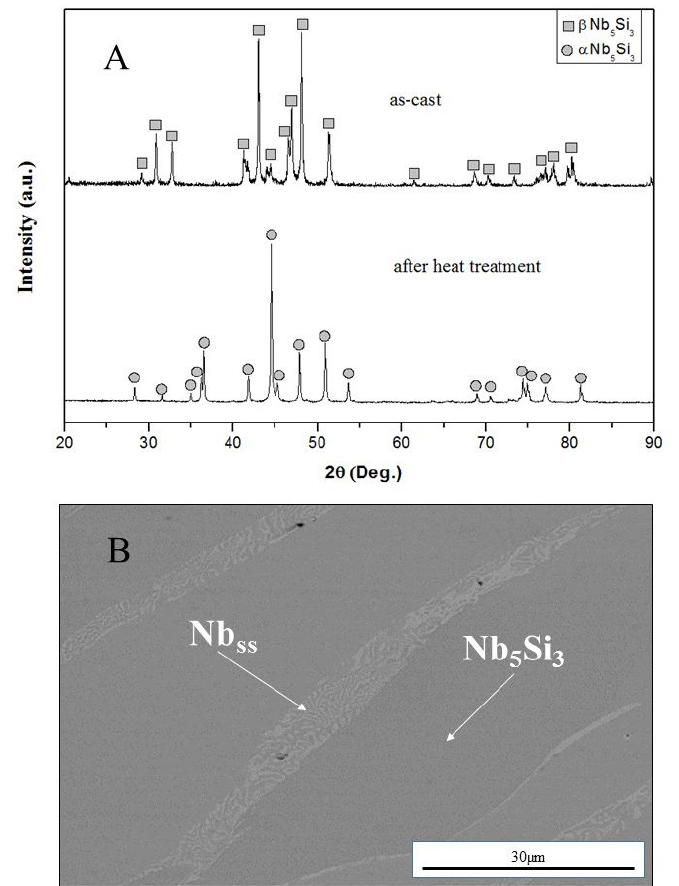
Figure 3. A X-Ray Diffraction before and after the heat treatment of the Nb-Si alloy and B SEM/BSE image of the microstructure of the Nb-Si alloy after the heat treatment at 1450 ° C/48